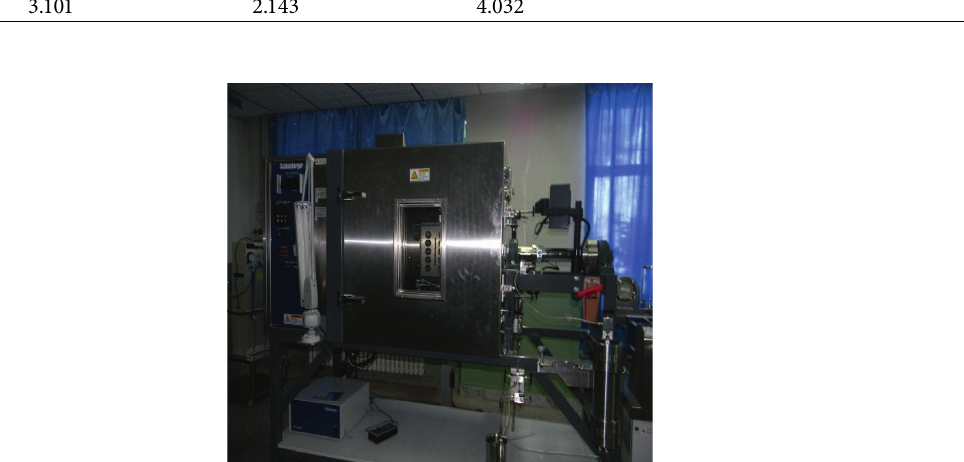
Figure 1: DBR all-visible mercury-free high-temperature and high-pressure multifunctional PVT Table 3: Two-phase flash experimental results of condensate gas with different CO